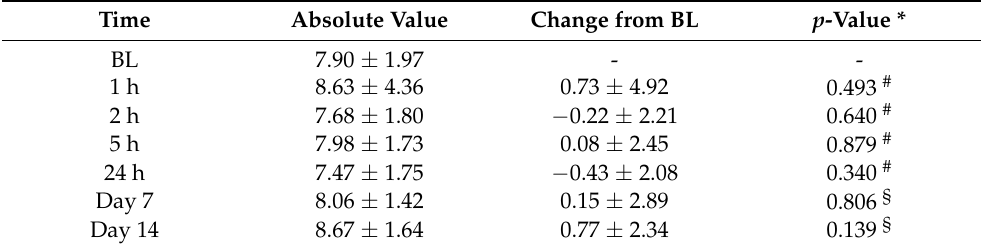
Table 4. Absolute transepidermal water loss (TEWL) measurement values (forearm, area A1) and changes from the baseline after a single application of the face wash gel (first 24 h) followed by twice-daily applications for 13